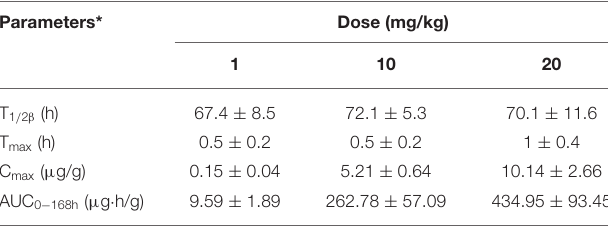
TABLE 2 | Pharmacokinetic parameters of tulathromycin in lung tissues following single dose intramuscular administration at 1, 10, or 20 mg/kg in H. parasuis infected guinea pigs (mean ± SD, n =